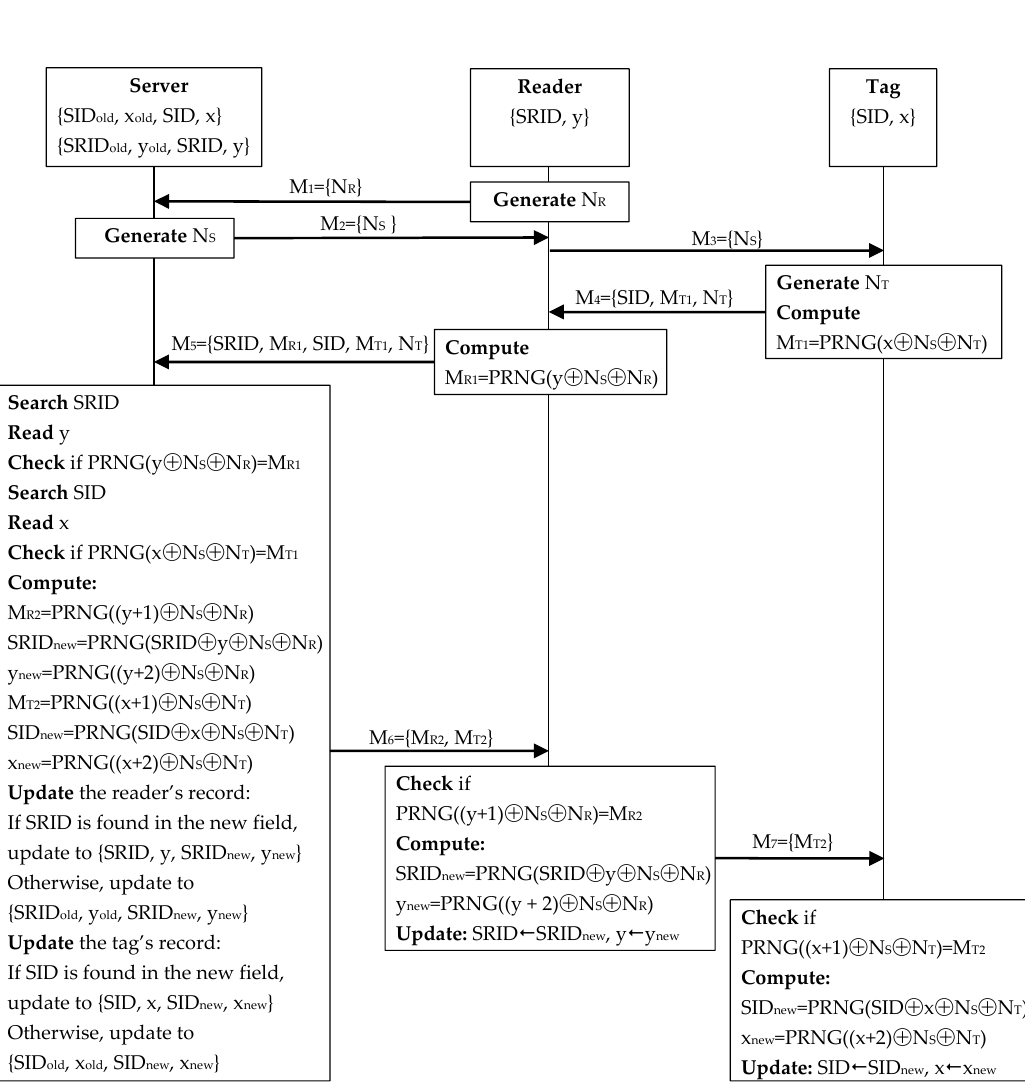
Figure 7. Authentication phase of our improved scheme.